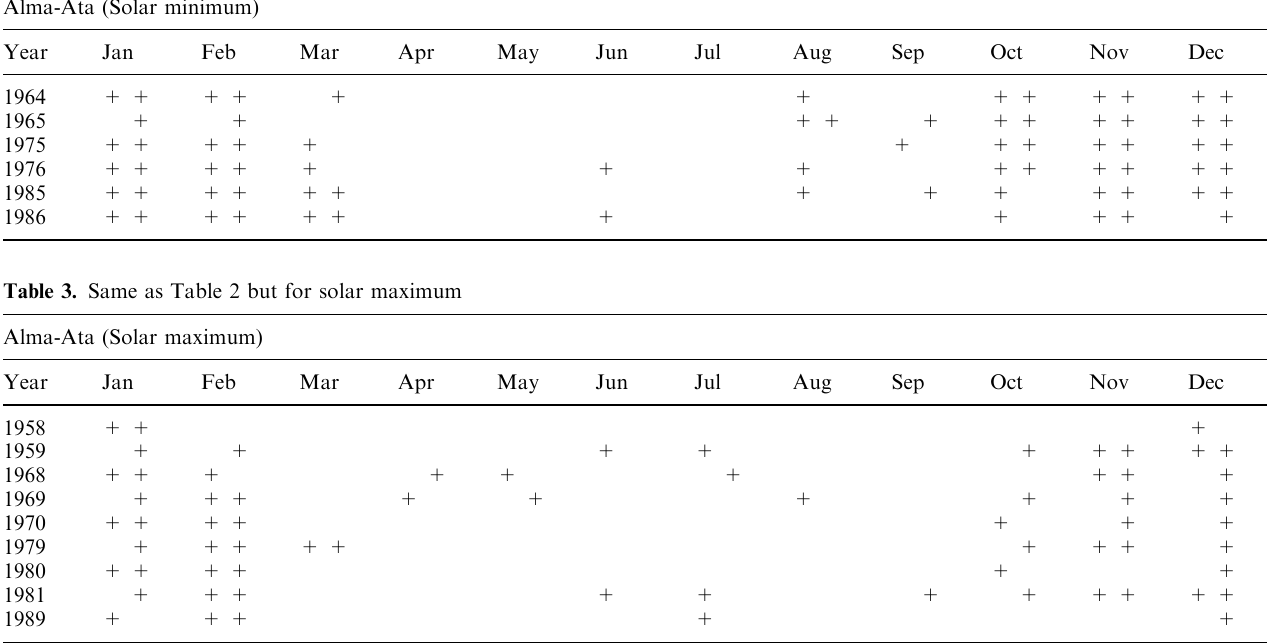
Table 2. Two peak occurrences in monthly median NmF2 variations solar minimum. Left-hand crosses, the 1st peak, right-hand crosses, the 2nd peak Alma-Ata (Solar minimum)